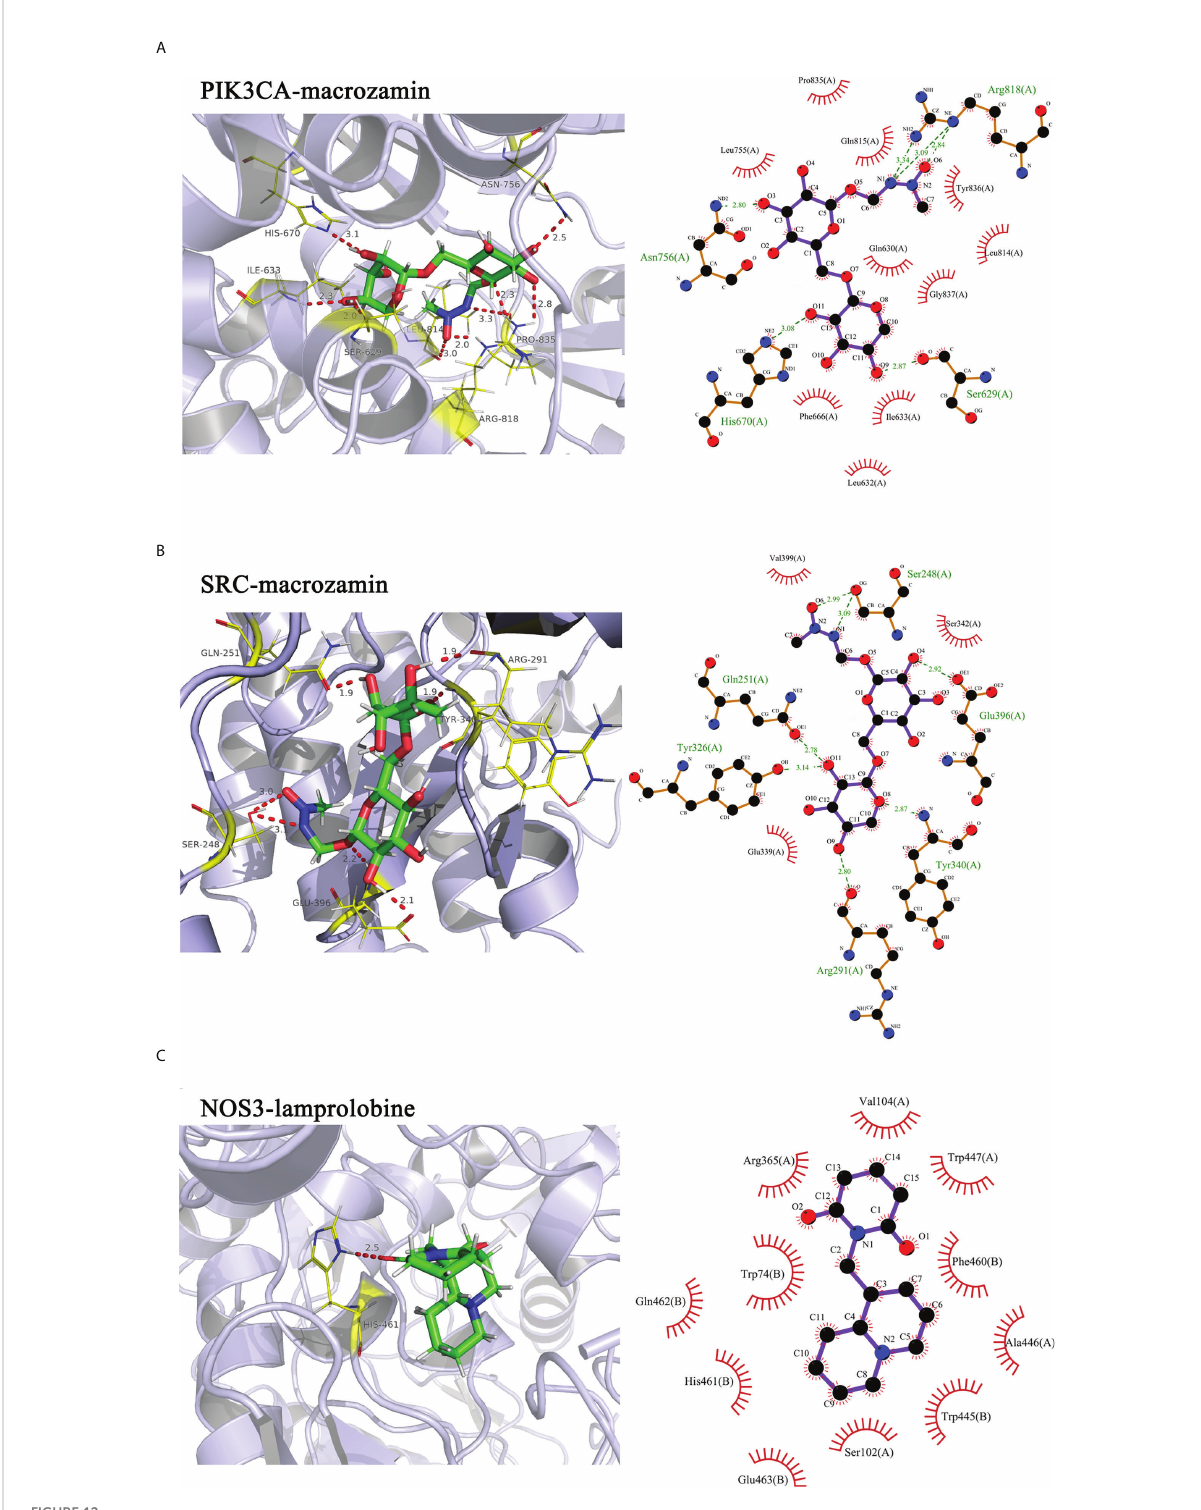
FIGURE 12 Molecular docking simulations of the interactions between the active components of CKI and the predicted targets. Notes: (A) PIK3CA- macrozamin; (B) SRC-macrpzamin; (C)